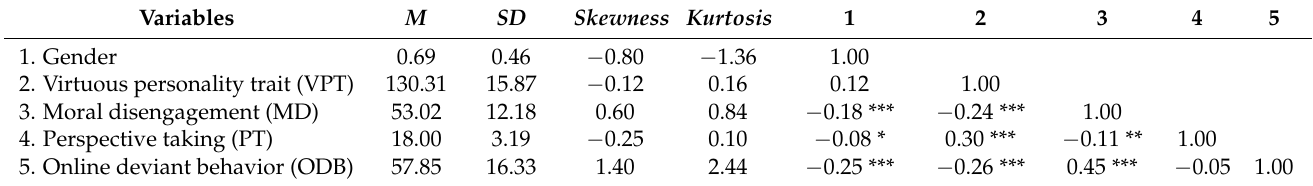
Table 1. Descriptive statistics and correlation matrix of all variables (N = 851).